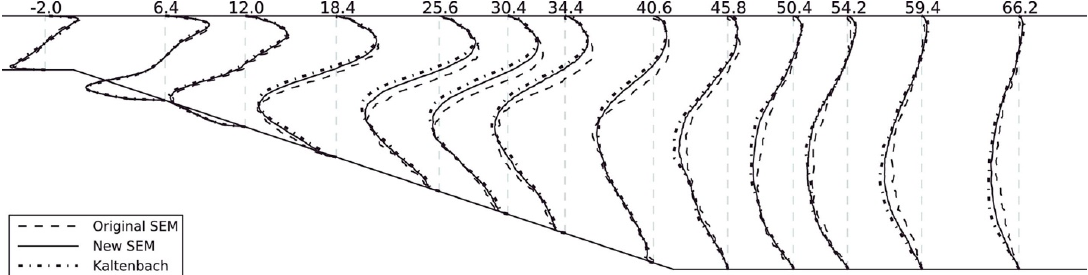
Figure 4. Profiles of turbulent shear stress (the number at the top of the figure indicates profile locations (the distance from the start of the incline, normalized by the initial boundary layer thickness)) [144].